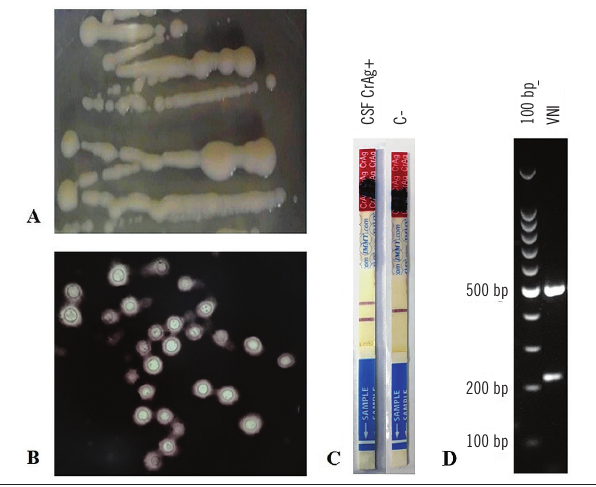
fIgure 3 – Cryptococcus neoformans identification A) C. neoformans culture on potato dextrose agar medium (37°C for 48 h); B) China ink preparation with typical encapsulated yeasts; C) CrAg-LFA ® positive in CSF from patient and CrAg-LFA ® negative (C-); D) electrophoretic profile of C. neoformans genotype VNI on 3% agarose gel with 100 bp DNA